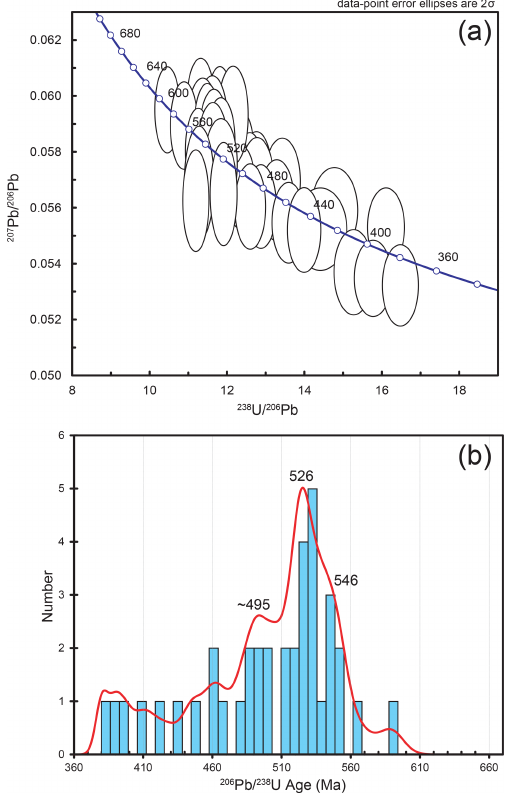
Figure 10. Tera–Wasserburg diagram (a) for the analyses between 589 and 380Ma, and (b) age histogram and probability density plot for the same ages.